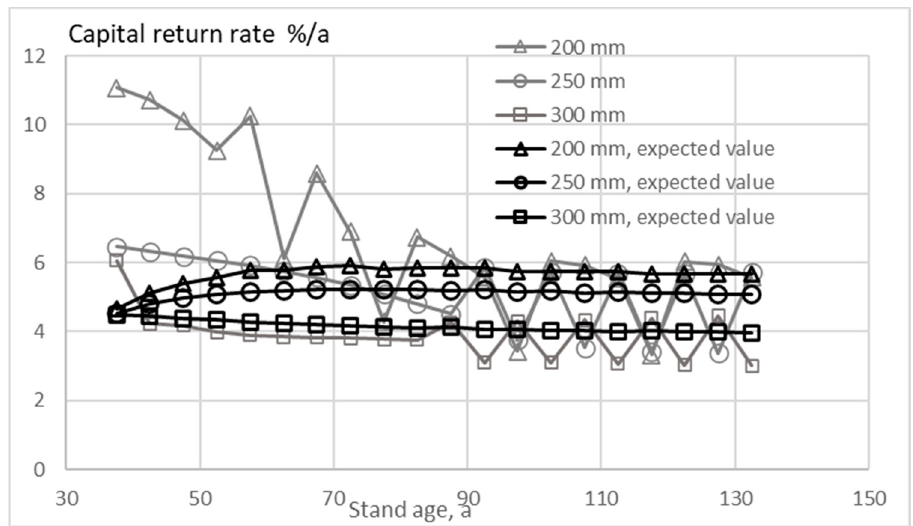
Figure 1. Annual capital return rate (thin markings) and expected value accumulated over stand age (thick markings) for three different cutting diameter limits (200 mm, 250 mm, and 300 mm).